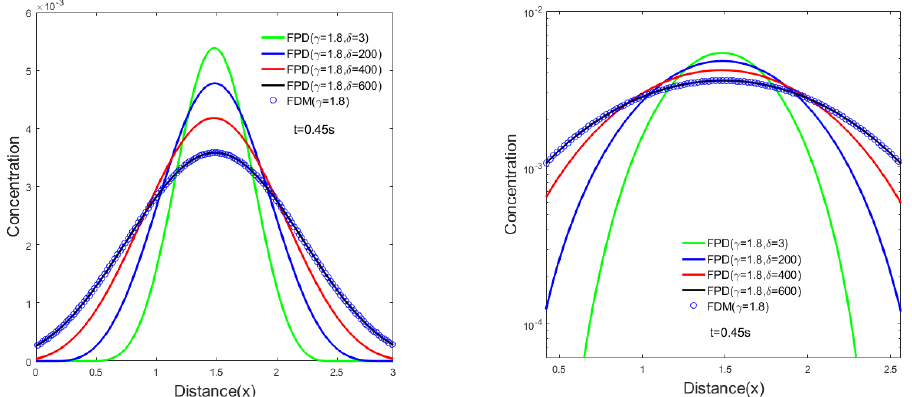
Figure 2. The concentration profiles using the FDM with space fractional index γ = 1.8 and the FPD model with space index γ = 2 at four near-fields ranges δ = m ( ∆ x ) : δ = 3, δ = 200, δ = 400, and δ = 600. Other model parameters were D α = 1.0, L = 3, and t = 0.45 s. The right plot is the semi − log form.